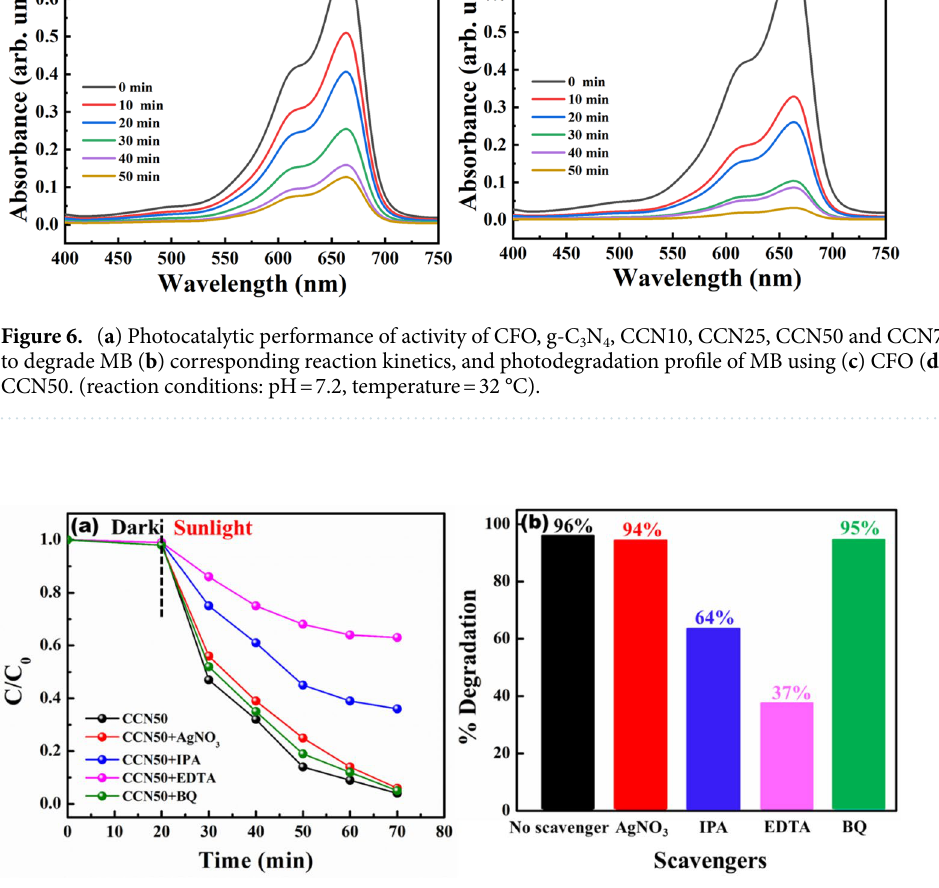
Figure 7. Comparisons of photocatalytic activities of CCN50 for the degradation of MB with and without various scavengers ( a ) C/C 0 plots ( b ) percentage of